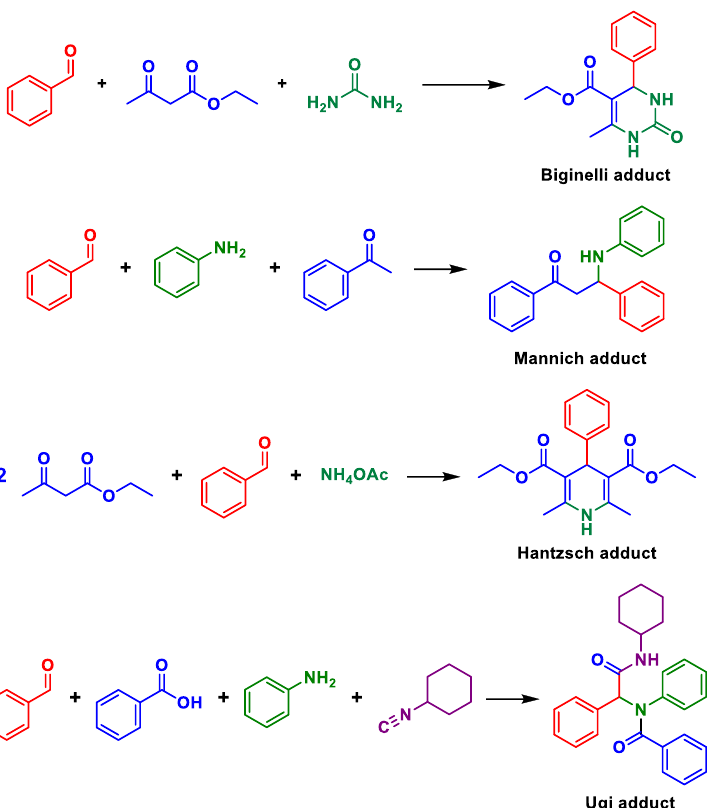
Scheme 1. Examples of popular and widely studied multicomponent